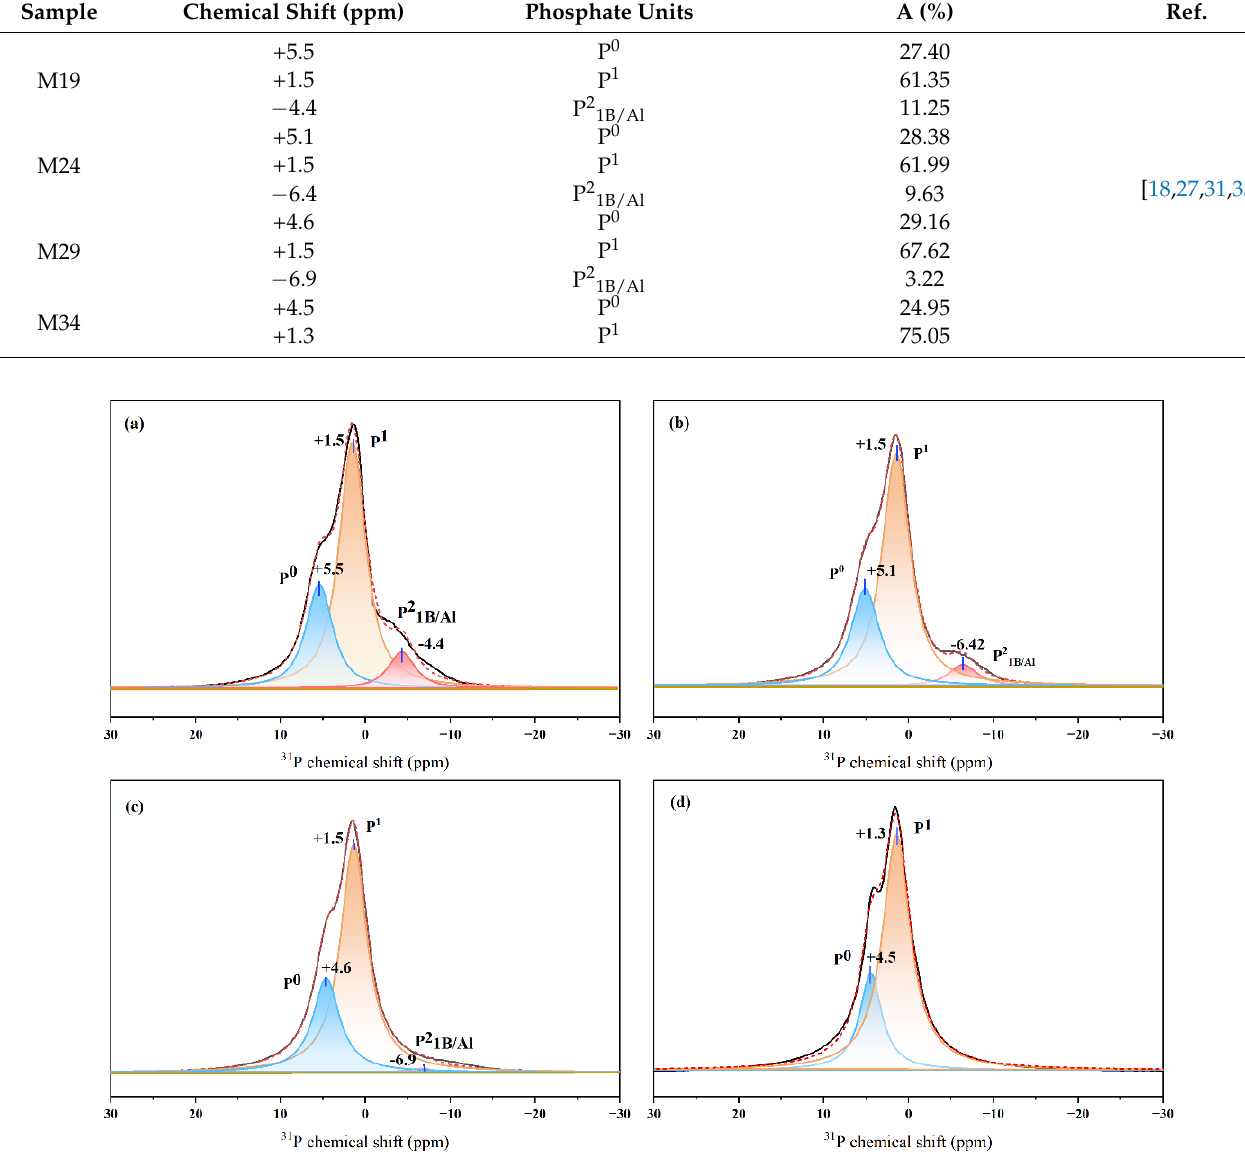
Table 4. 31 P MAS NMR fitting parameters (Chemical shift and relative area